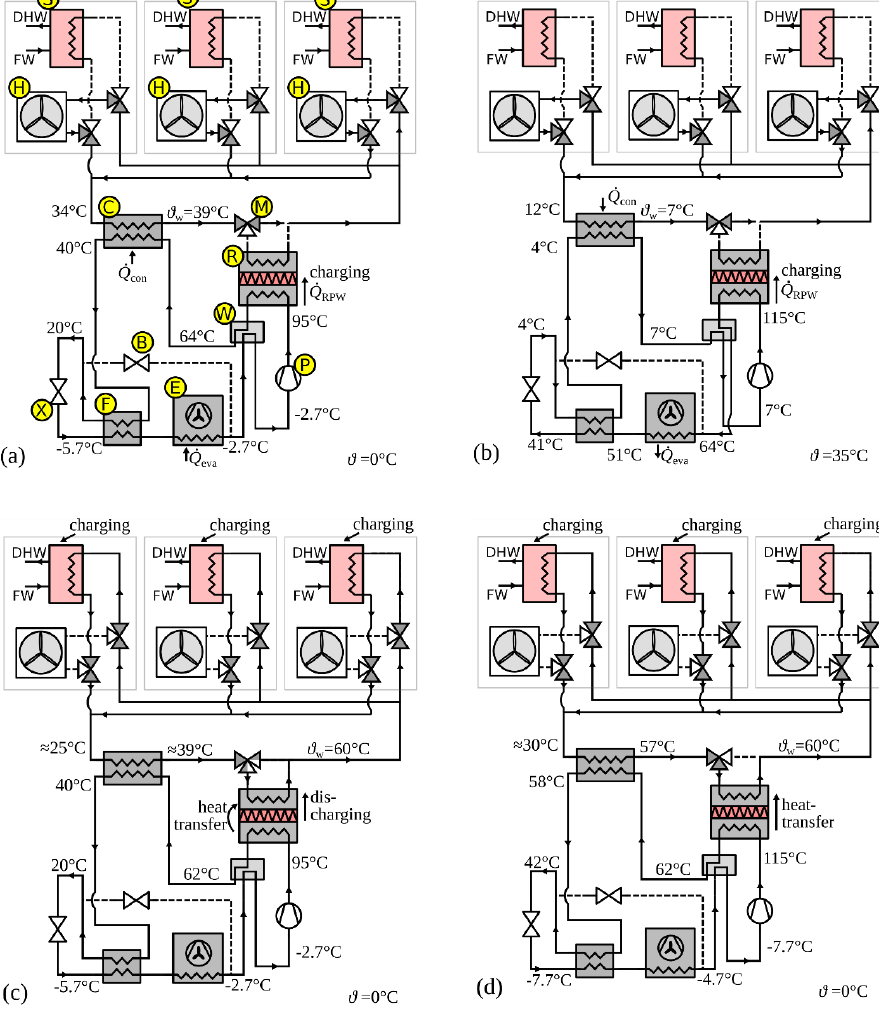
Figure 1. Concept of the proposed system for an example scenario with three apartments during: ( a ) heating operation, ( b ) cooling operation, ( c ) energy efficient domestic hot water (DHW) generation by discharging the RPW-HEX and ( d ) direct DHW generation. (S) Decentralized sensible DHW storage, (H) fan-coils suitable for heating and cooling, (C) condenser, (R) RPW-HEX, (W) four-way valve, (B) bypass expansion valve, (X) regular expansion valve, (F) fluid phase heat exchanger, (E) evaporator and fan, (P) compressor, (M) three-way valve. The temperatures indicated in ( a , b , d ) were taken from steady-states at a state of charge (SoC) of 50% for heating and cooling, respectively, whereas they were taken shortly after switching from mode (a) to (c) in ( c ). The ambient temperature ( ϑ ) was 0 ◦ C in ( a , c , d ) and 35 ◦ C in ( b